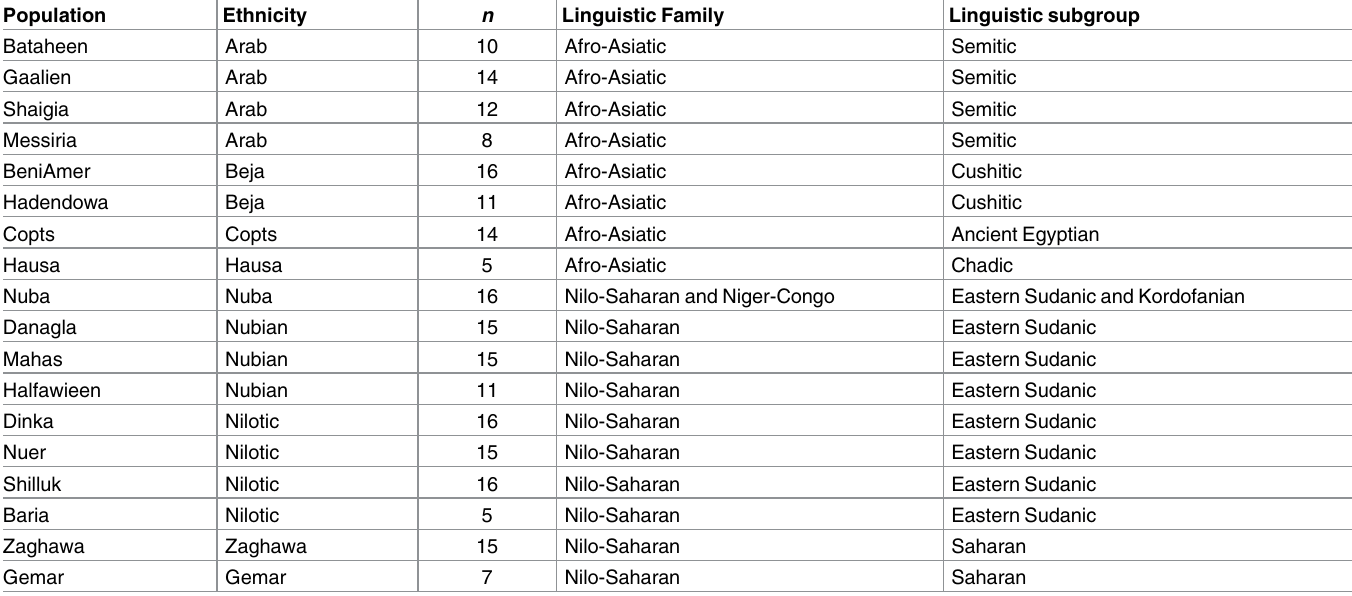
Table 1. Population names, sample sizes, ethnic and linguistic affiliations of the populations.